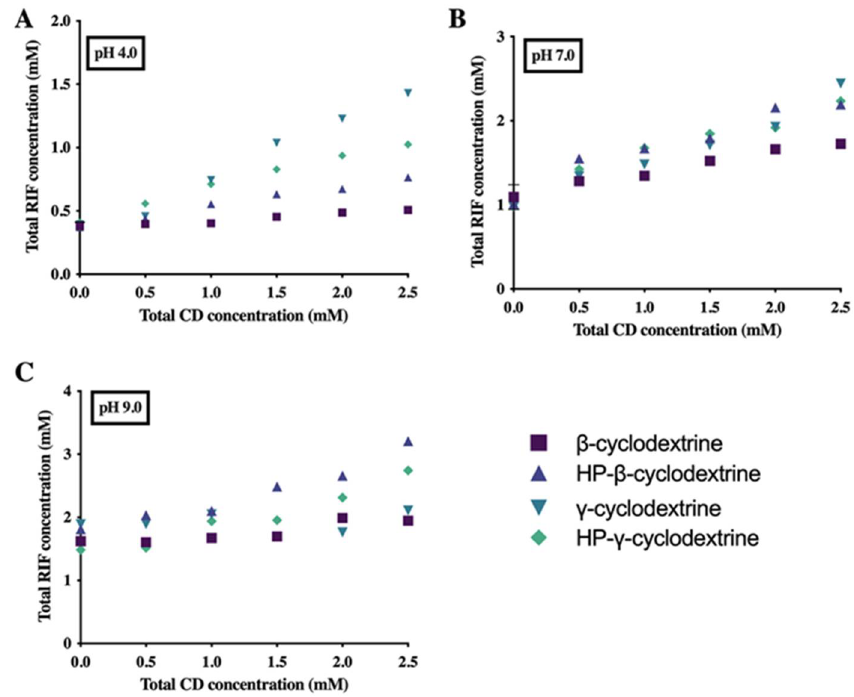
Figure 5. Phase solubility diagrams of RIF with β CD, HP- β CD, γ CD, and HP- γ CD in ( A ) pH 4.0, ( B ) pH 7.0, and ( C ) pH 9.0.